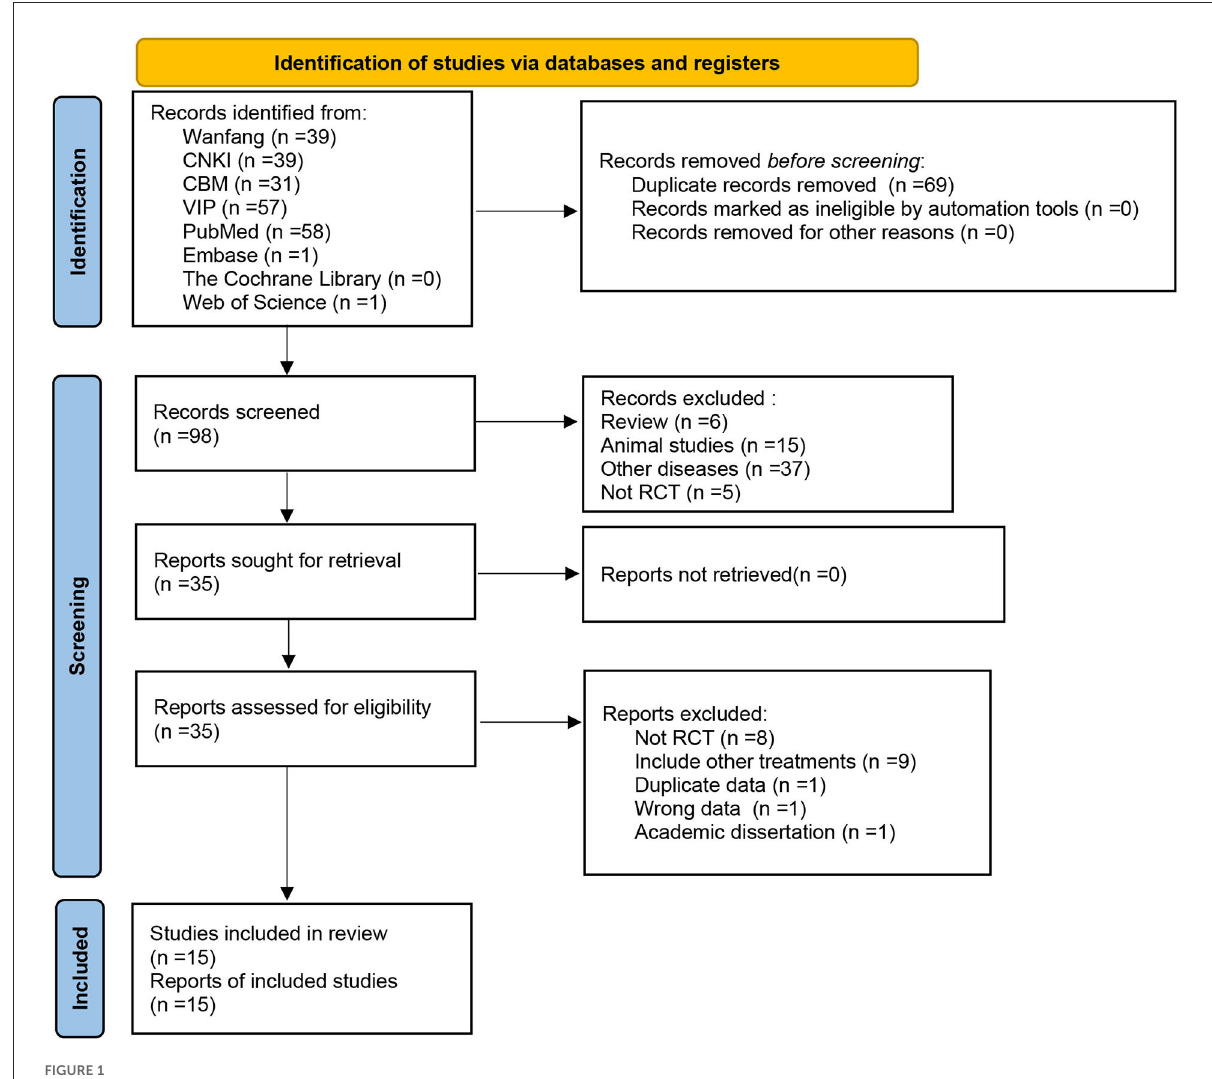
FIGURE1 Flow diagram of literature